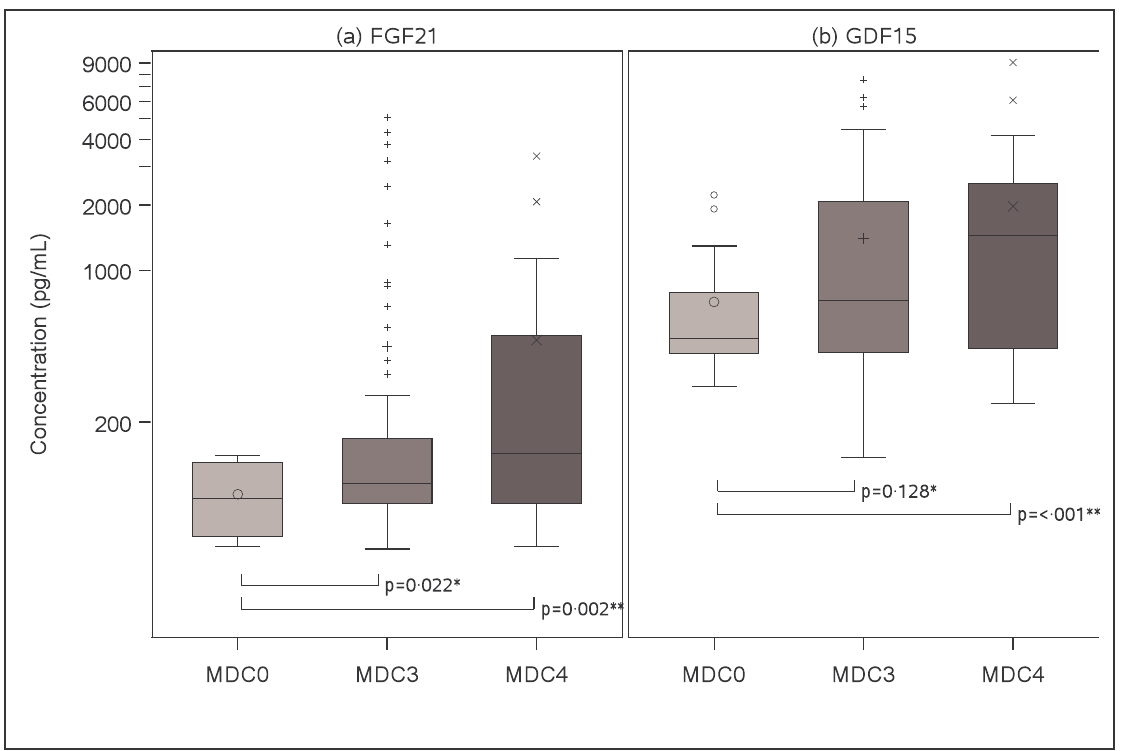
Fig 2. Plasma mitokine concentrations based on case status. (a) Distributions of FGF21 values are shown across MD cases and controls as determined in plasma from the timepoint closest to MDC case definition. (b) GDF15 distributions across “possible” MD cases and controls from same plasma timepoint as in (a). Plasma values of each mitokine determined in duplicate via ELISA. Bottom and top box edges represent quartiles one and three, respectively, while horizontal line within box indicates group median. Vertical error bars indicate one and a half times the interquartile range, with individual observations outside that range displayed as small icons (circles, crosses, and X’s). The largest icon for each group indicates the mean value. � Wilcoxon rank sum test comparing MDC3 to MDC0 controls . �� Paired Wilcoxon rank sum test comparing MDC4 to MDC0 controls . FGF21 = fibroblast growth factor 21; GDF15 = growth differentiation factor 15; MDC = mitochondrial disease criteria.